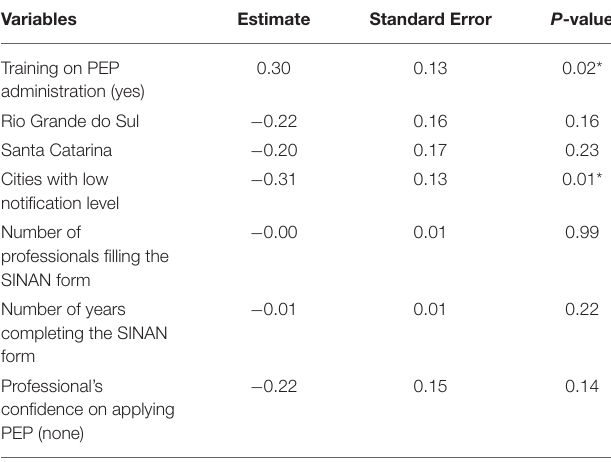
TABLE 1 | Factors influencing the professional’s PEP Knowledge Score